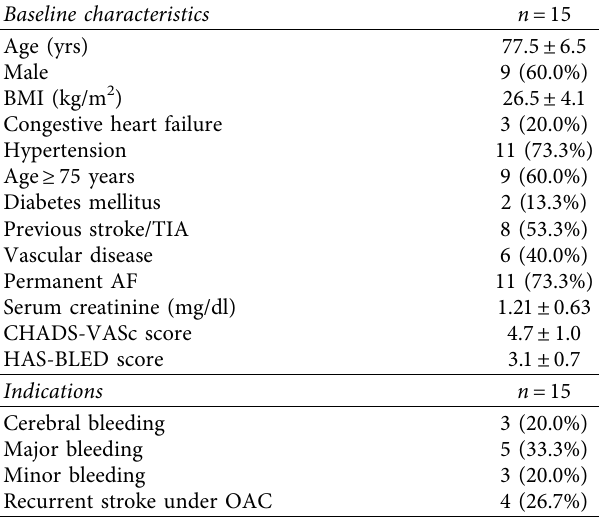
Figure 1: Illustrative case of a 70-year-old man with paroxysmal atrial fibrillation, CHADS-VASc score of 4, HAS-BLED score of 4, and previous intracranial haemorrhage scheduled for LAAO. Measurements of the os and landing zone, respectively, by 3D TEE were 23 × 31 mm and 19 × 22mm, and those by CT were 22 × 30mm and 19 × 22 (18.6 × 21.9mm, left panel). Standard of care assessment had chosen for a 25 Amulet, with team’s confidence 6 out of 10. FEops 3D rendering volume showed a chicken wing morphology (middle panel). Computation simulation of a 22 Amulet revealed limited compression (5.0 to 5.9%) and apposition both in proximal and distal positions, while a 25 Amulet had a better compression (12.6 to 14.4%) and apposition (see colour code, green 0 mm distance between device and appendage and red 2 mm) with good sealing of the os. A 25 Amulet with distal position was chosen with confidence 8 out of 10. Postimplantation images showed perfect position and sealing (right panel). Table 1: Baseline characteristics and clinical